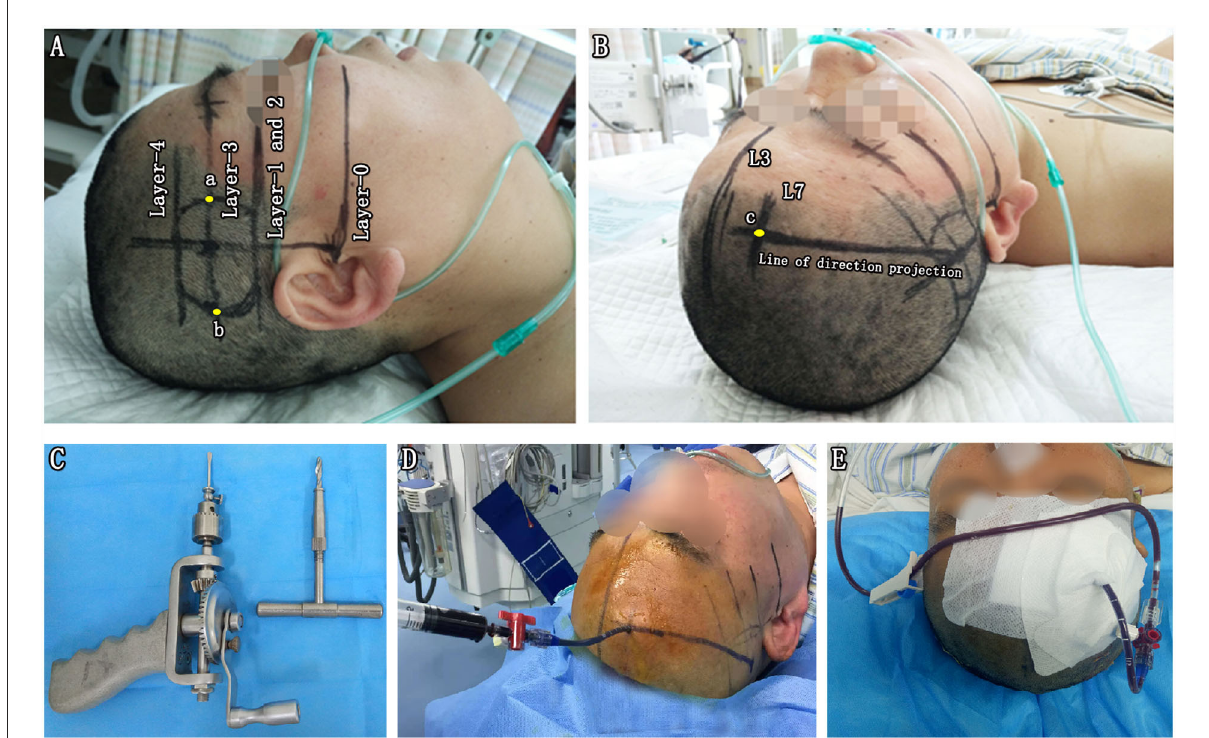
FIGURE2 Parameter reproduction on a patient’s head and free-hand catheter technique. (A) Reproducing the actual baseline plane of the CT scan on the patient’s head and outlining the sagittal projection of the hematoma border. With the help of a triangle ruler, two parallel baselines were drawn passing through the external auditory canal (Layer-0) and eye’s lenses (Layer-1) with the distance of D1. Next, the CT scan axis was drawn through the external auditory. The projection lines of the bottommost (Layer-2), largest (Layer-3), and uppermost (Layer-4) layers of BGH were depicted on the ipsilateral temporal skin, according to the distance (D2, D3, and D4) to Layer-0. Layer-1 and Layer-2 exactly coincided in this case. On the projection line of Layer-3, the projection points of the anterior (point a) and posterior (point b) borders of the hematoma were marked according to D5 and D6. (B) The midsagittal line L3 and paramedian sagittal line L7 were drawn with the reference of D7. The puncture point (point c) was located at the forehead area between 2cm above eyebrow arch and coronal suture away from the vascular and functional distribution of brain tissue. A marking line of the puncture direction was drawn from point c to the center of the temporal skin projection area of the BGH. (C) A hand drill and a reamer. (D) Aspiration with a 5-mL syringe. (E) Hematoma drainage. BGH, basal ganglia